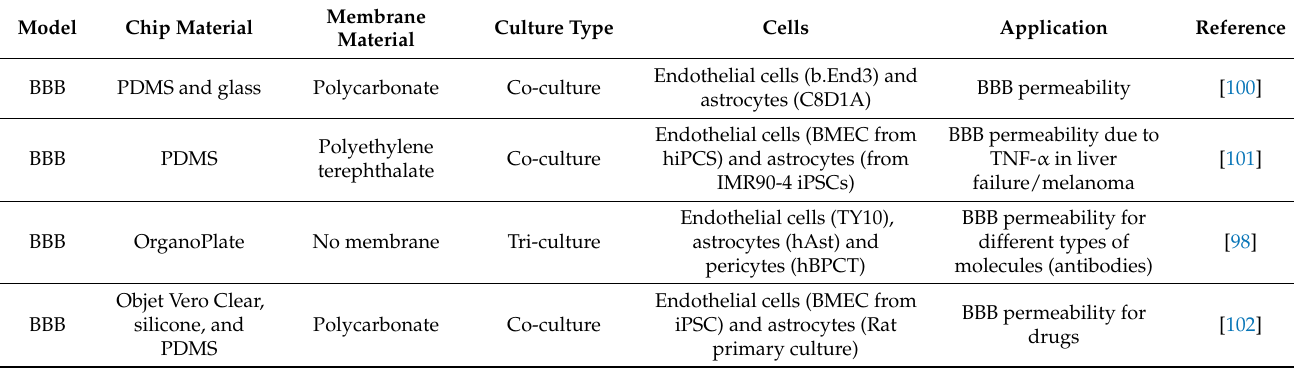
Table 4. BBB-on-a-chip and NVU-on-a-chip